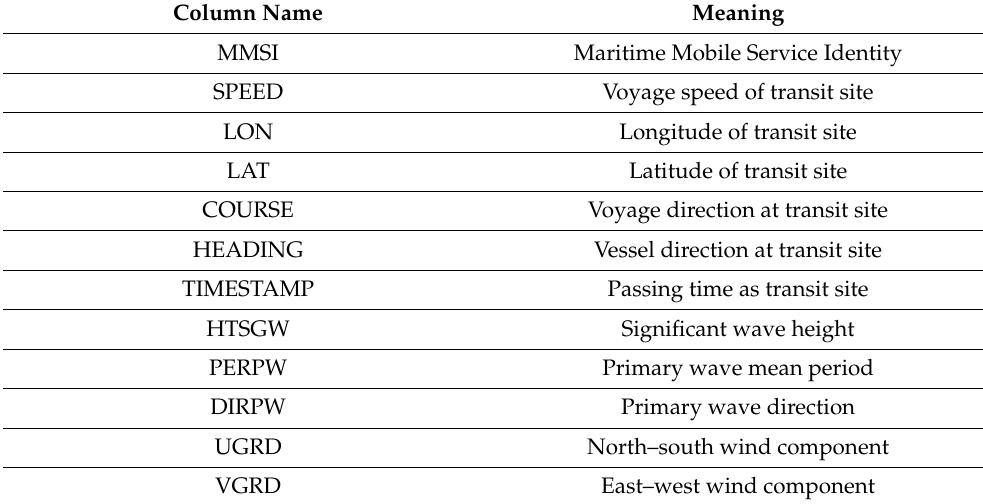
Table 3. Meaning of Table 2